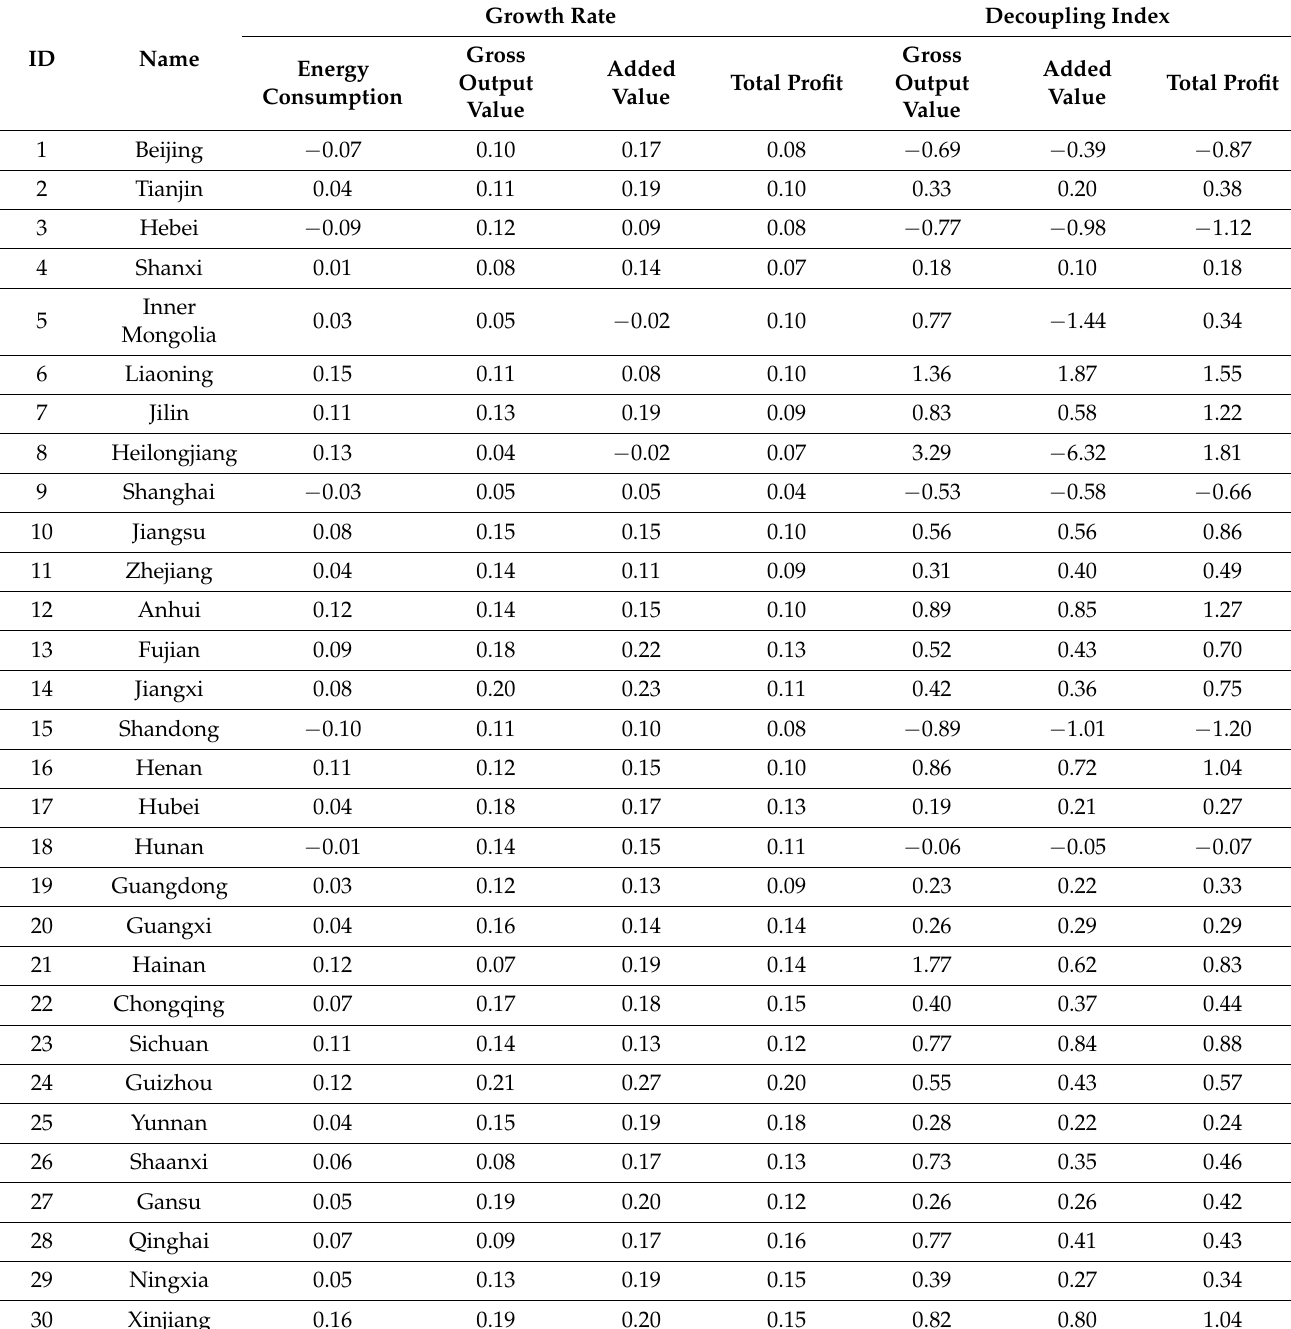
Table A1. Growth rate on construction energy consumption and construction economy and decou- pling index between the two from 2010 to